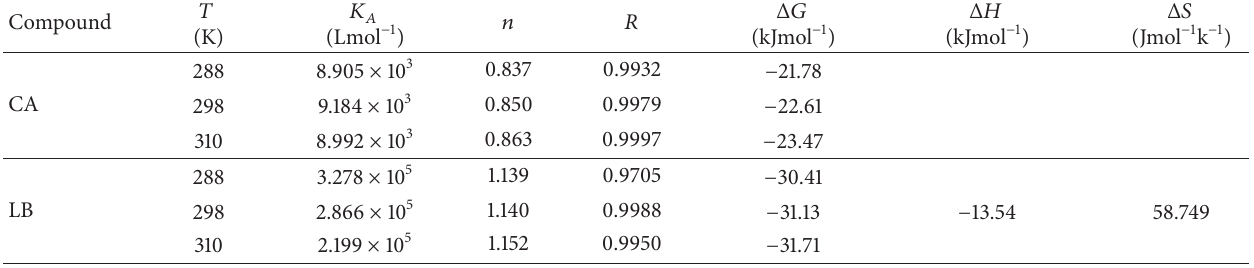
Table 2: The binding constants and thermodynamic parameters of CA-BSA and LB-BSA systems at different temperatures. Compound